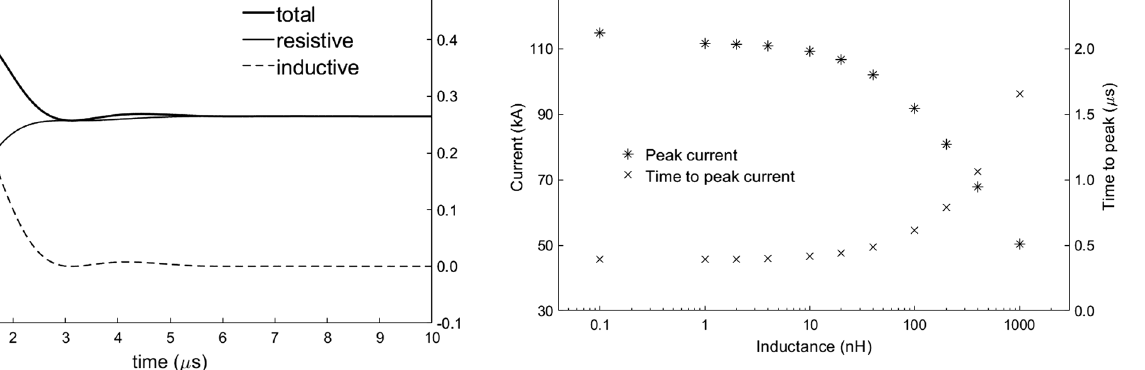
FIG. 4. The energy deposition calculations into a matched 60- nH coil. The thick solid line is the total energy delivered to the coil, the thin solid line is its resistive part, and the thin dotted line is its inductive part.